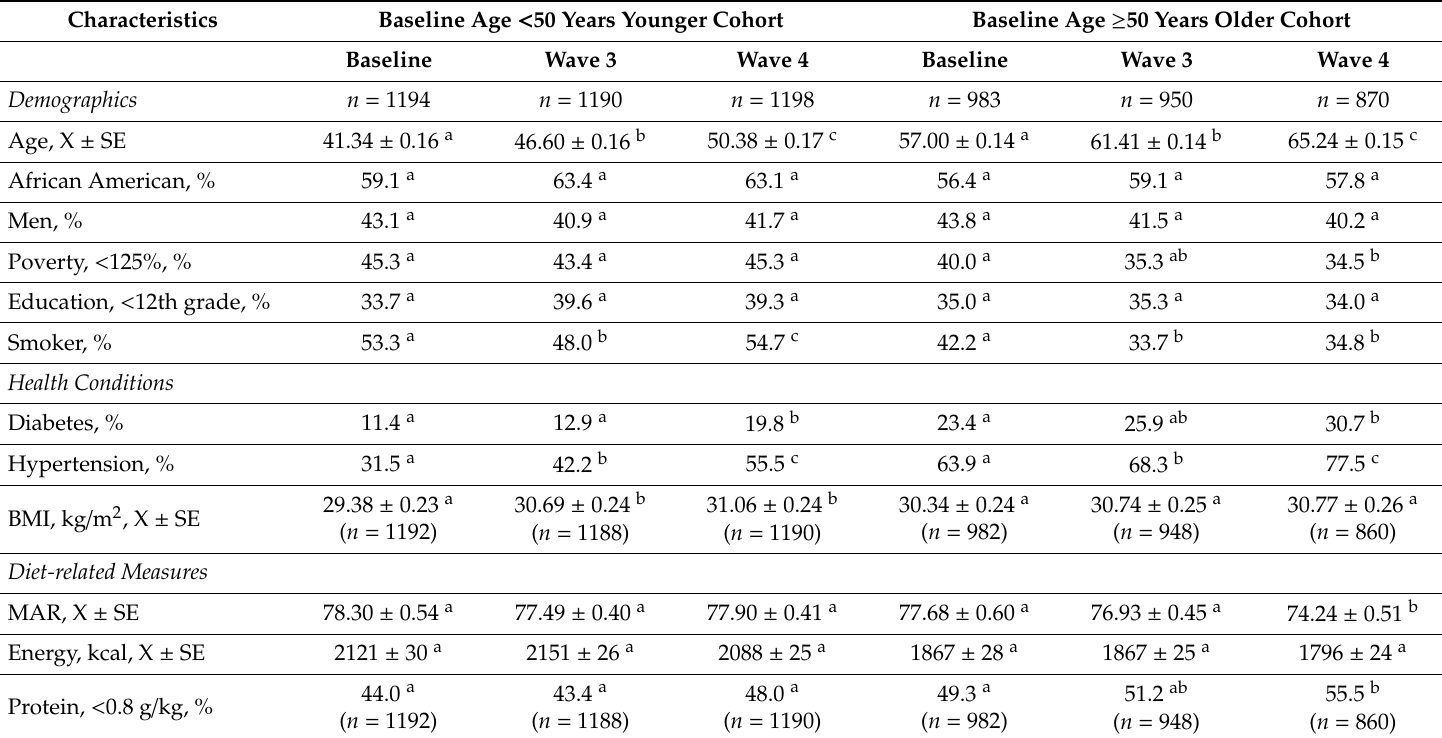
Table 1. Demographic and health characteristics and diet quality categorized by age at baseline of individuals examined in the HANDLS Study, 2004–2017.